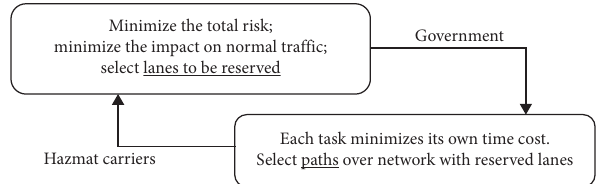
Figure 1: Conceptual structure of the bilevel hazmat lane reservation